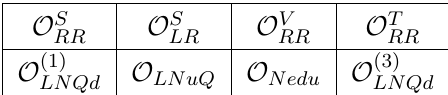
Table 1 . The origin of low-energy effective operators from SMNEFT in the operator basis of ref.